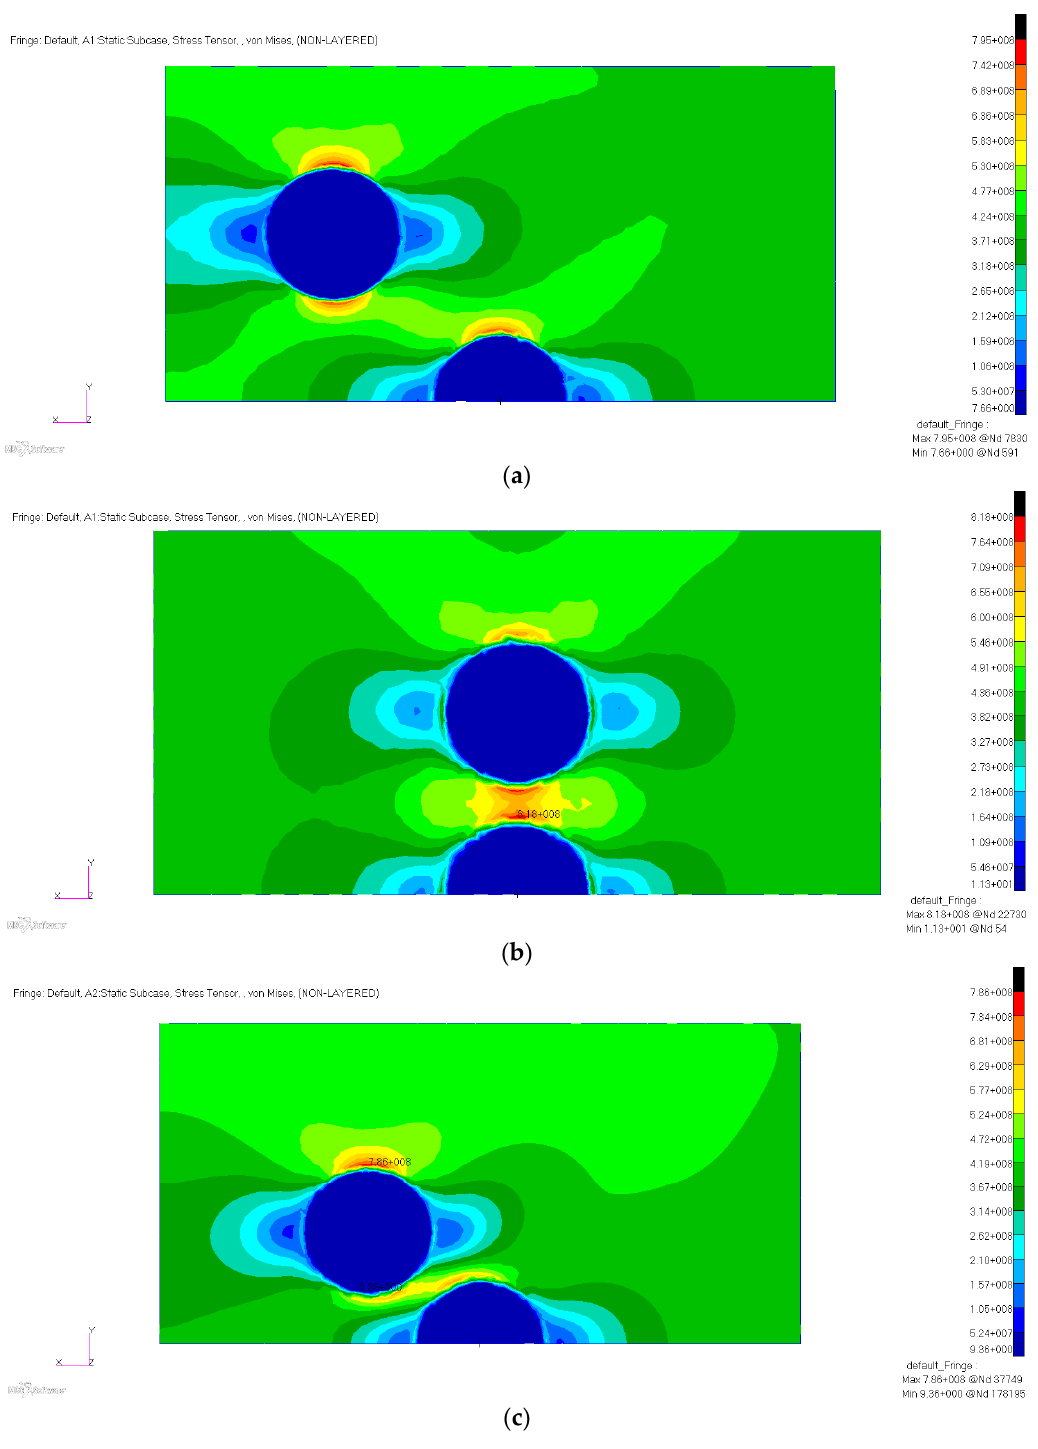
Figure 18. Von Mises stress distribution with respect to spherical inclusions ( a ) placed at 45° at 0.085 mm, ( b ) placed in the median plane at 0.05 mm, and ( c ) in an overlapping position in the perpendicular plane at 0.05 mm.